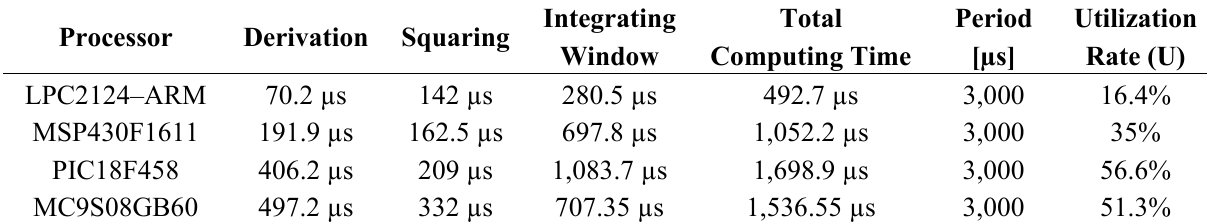
Table 1. Computation time for the Pan and Tomkins algorithm.